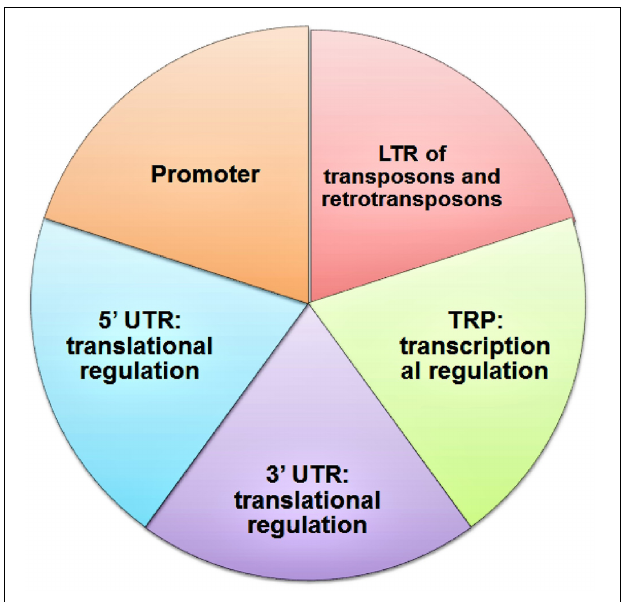
FIGURE 3 | Putative role of G quadruplex in plants during physiological